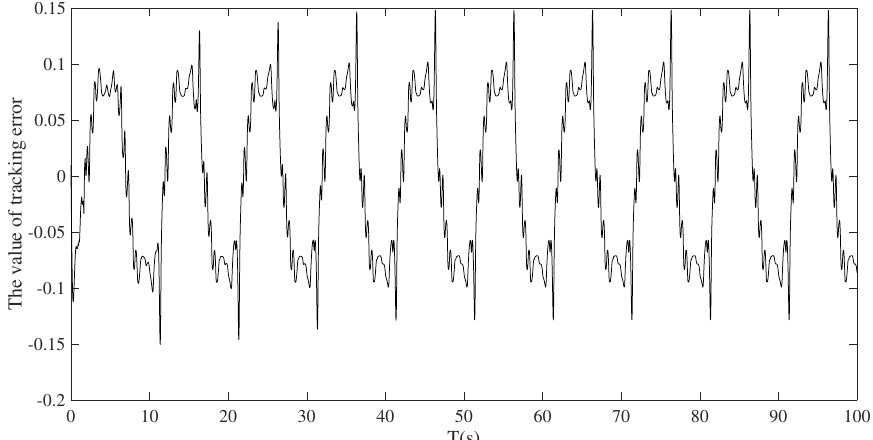
Figure 12. Adaptive compensation laws in unknown time-varying delay form (without dead-zone